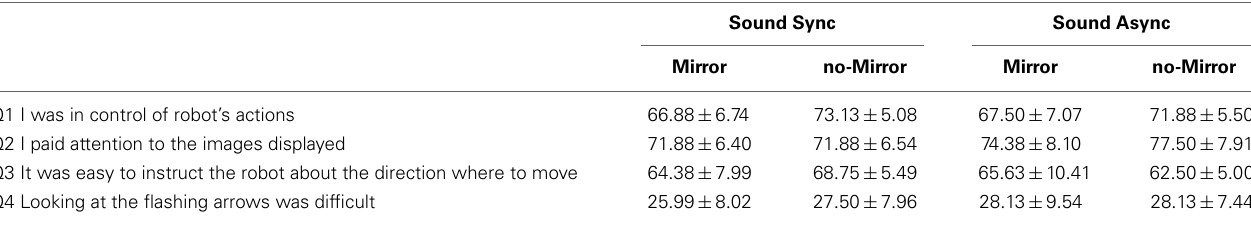
Table 2 | Participants answers to questions assessing the quality of the